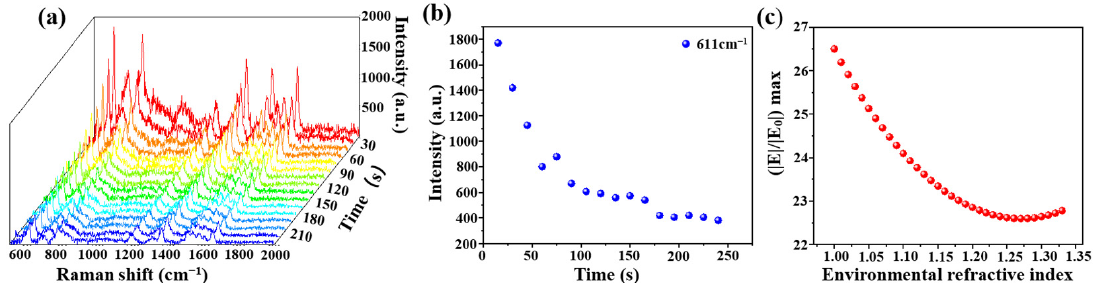
Figure 8. ( a ) Raman time mapping of R6G (10 − 6 mol/L, at a 15 s interval); ( b ) the relationship between Raman intensity at 611 cm − 1 and testing time and ( c ) the relationship between (|E|/|E 0 |) max and environmental refractive index with the COMSOL simulation.